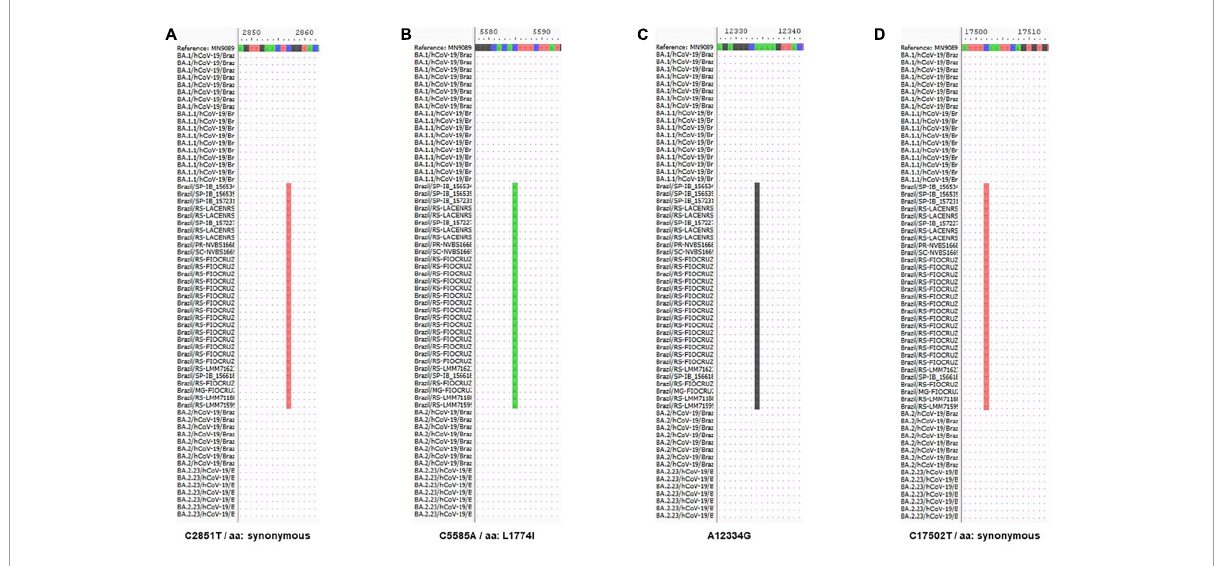
FIGURE4 Molecular characterization of recombinant XAG. Alignment of sequences from Omicron subvariants BA.1 and BA.2, which originated the recombination that generated the XAG recombinant showed four distinct markers (in red) of this recombinant at positions (A) 2,857 (C/T), (B) 5,585 (C/A), (C) 12,334 (A/G), and (D) 17,502 (C/T). The mutation at positions 2,857 and 17,502 generate synonymous mutations and the mutation at position 5,585 (L1774I) is exclusive to this